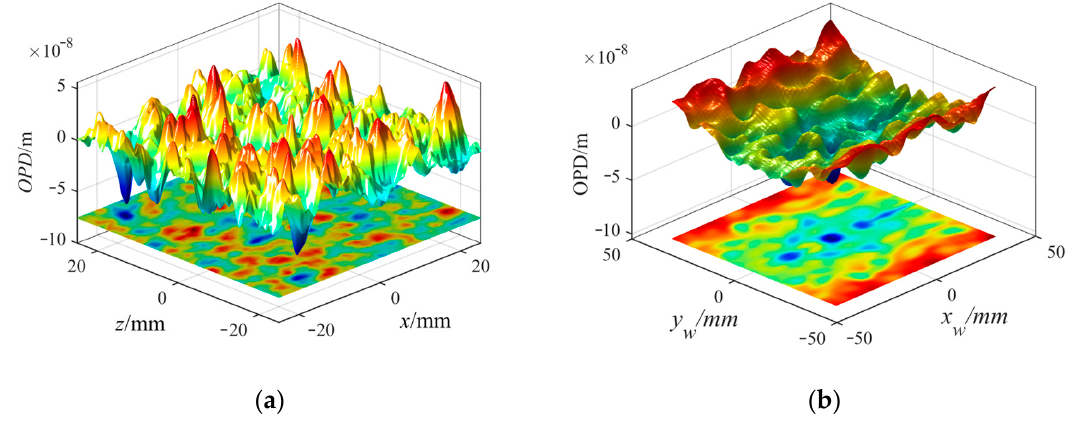
Figure 8. ( a ) OPD of the turbulence density proxy model; ( b ) OPD of the flow field by the CFD. The amplitude spectrum model, density proxy model, and CFD flow field in the